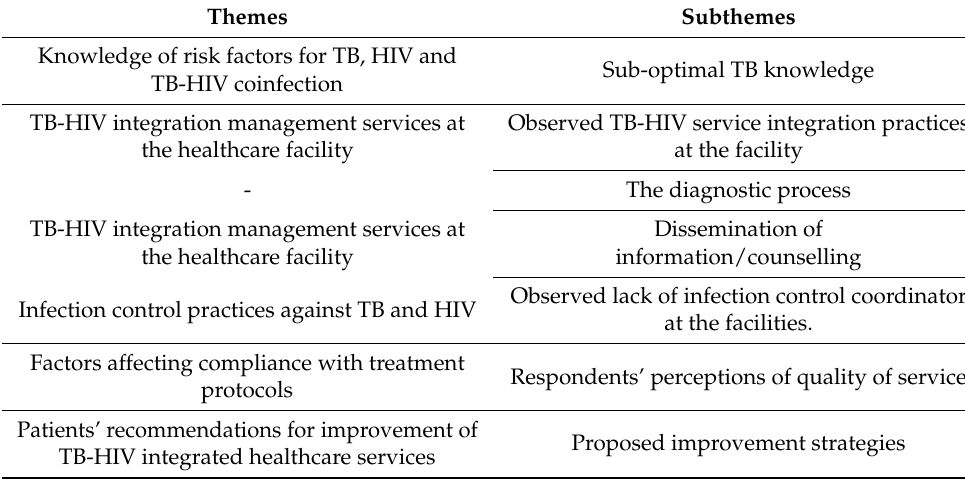
Table 2. Patients’ perceptions about the quality of integration of HIV, tuberculosis and primary healthcare services in OR Tambo District